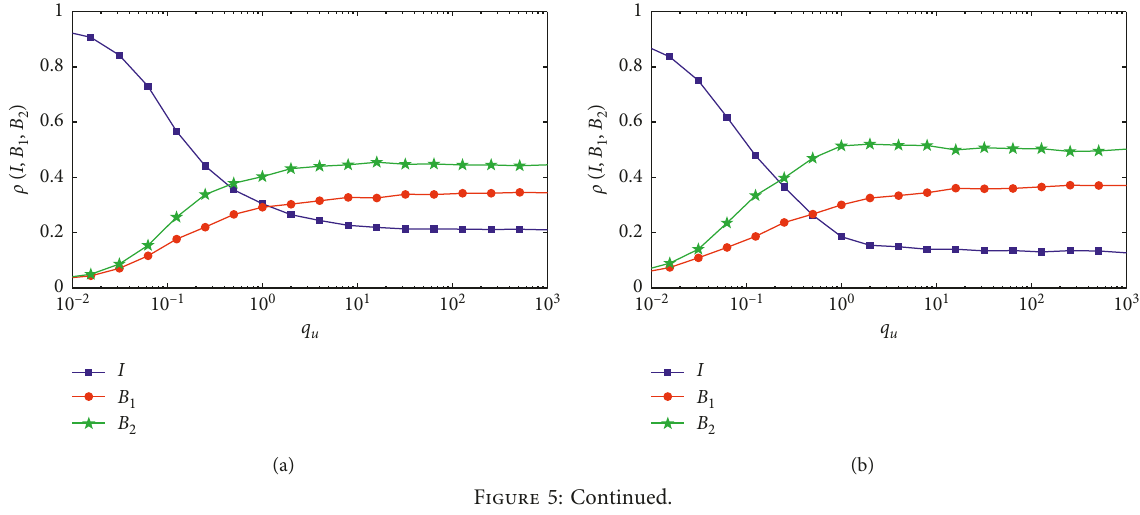
Figure 4: The values of ρ and ε � 0.1. (a) Hamsterster ; (b) Simmons81 ; (c) Oberlin44 ; (d) Bowdoin47